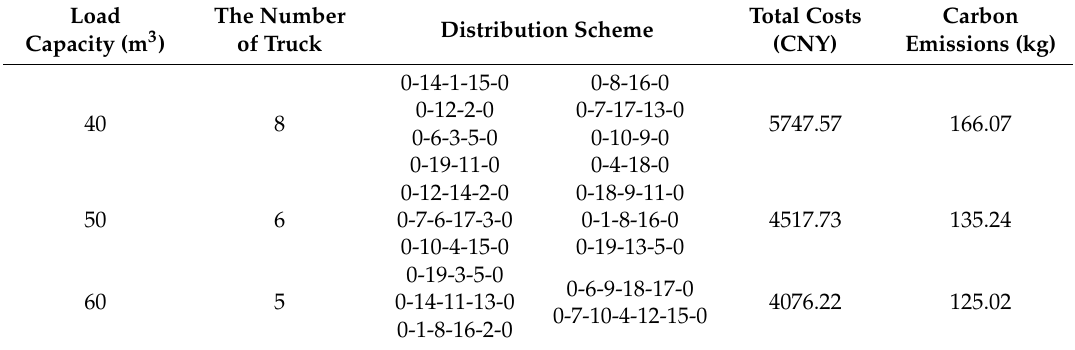
Table 6. Distribution schemes with the different maximum load capacity of oil tank